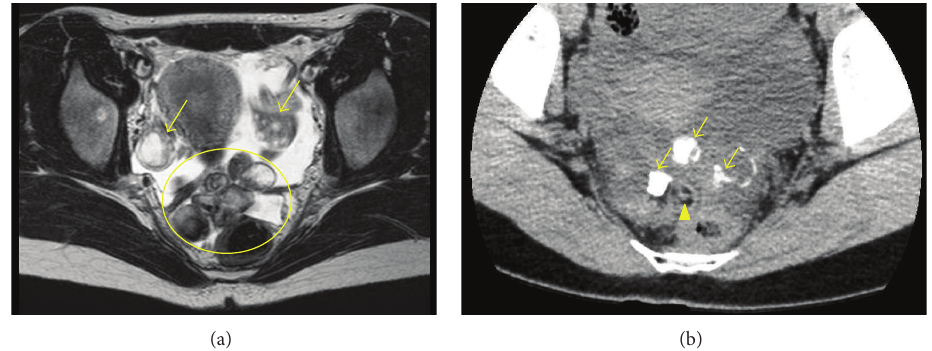
Figure 1: (a) T2 weighted magnetic resonance imaging showing a multicystic mass (circle) and normal ovaries (arrows). (b) Computed tomography showing calcified (arrows) and fatty (arrow head) components in the mass.